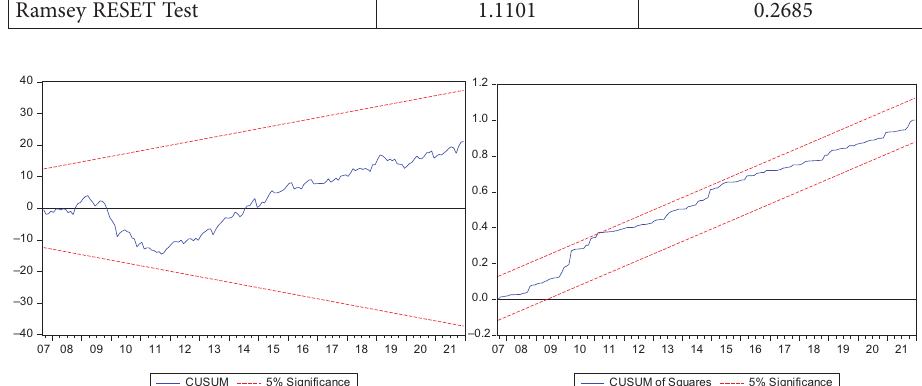
Figure 4. CUSUM and CUSUMSQ Test Results (source: own calculation of